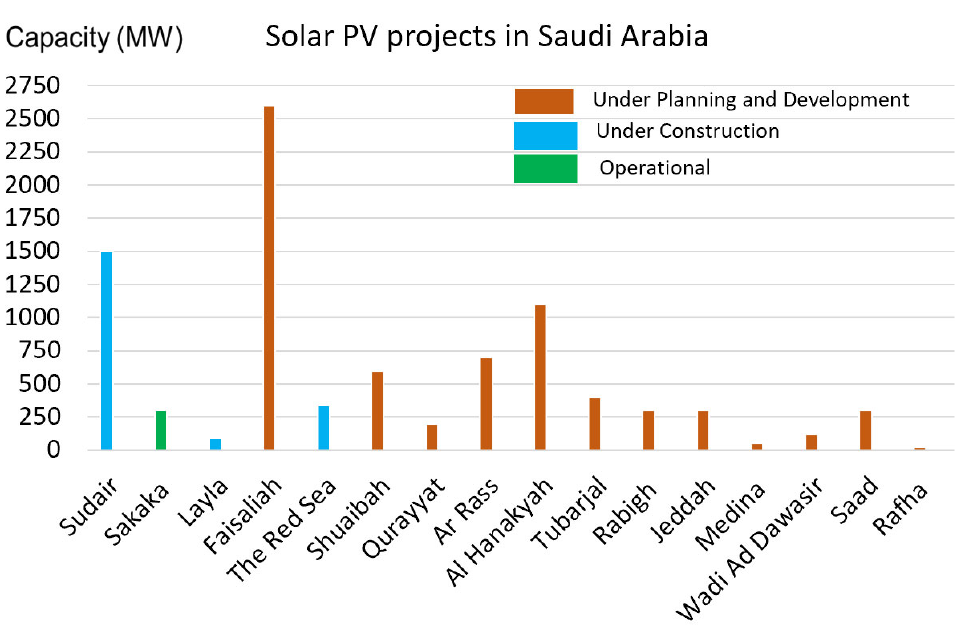
Figure 2. The current status of Saudi Arabia’s solar PV projects, along with their respective power capacities.